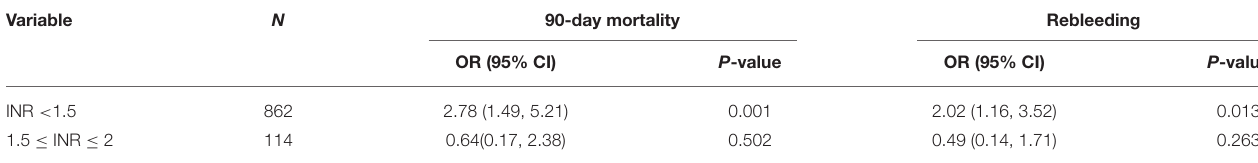
TABLE 4 | Association between FFP transfusion of 90-day mortality or rebleeding in subgroup analysis. Variable